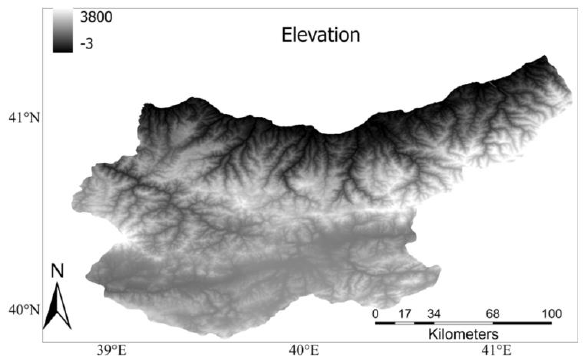
Figure 2 . Altitudes within the study area, from EU-DEM v1.1 (2023).